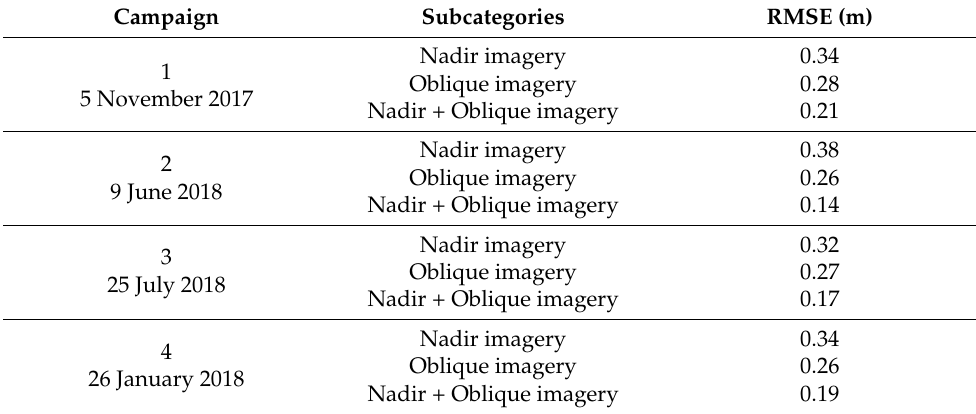
Table 7. RMSE between the derived DSMs and the GNSS